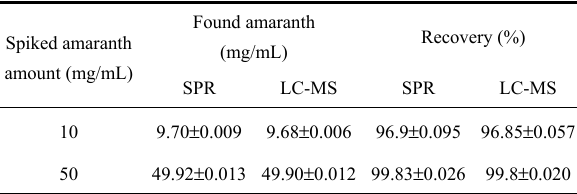
Fig. 10 Real-time kinetic analysis of amaranth in the spiked fruit juice samples. Table 3 Recoveries of amaranth in fruit juice samples (the number of repetitions in experiments, n